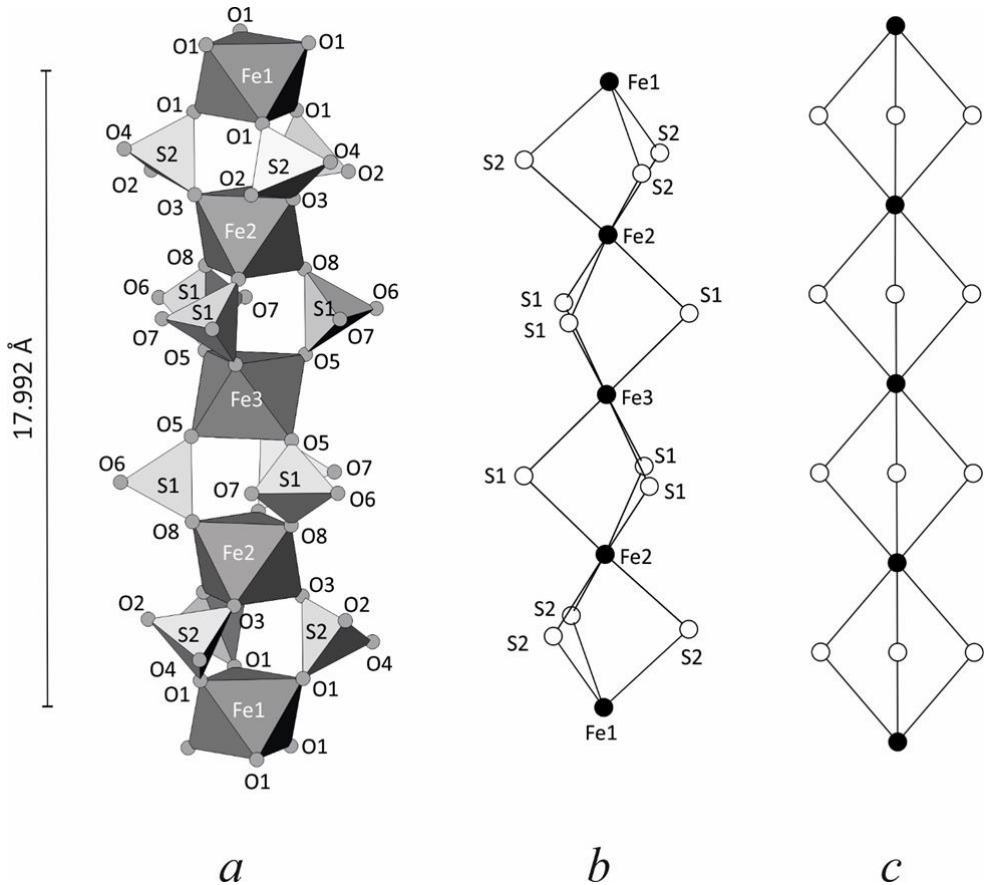
Figure 6. ( a ) The anionic [(Fe,Al)(SO 4 ) 3 ] 3− chain in (K,Na) 3 Na 3 (Fe,Al) 2 (SO 4 ) 6 , ( b ) its 1D graph, and ( c ) the idealized graph with 6-connected black and 2-connected white vertices. and ( c ) the idealized graph with 6-connected black and 2-connected white